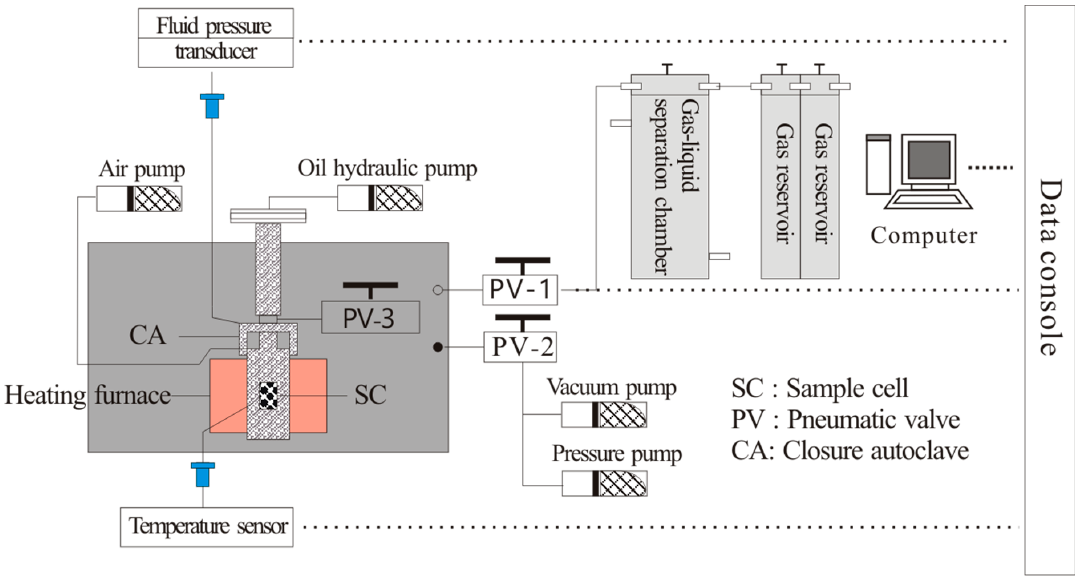
Figure 2. Schematic diagram of thermocompression pyrolysis experiment system [21].